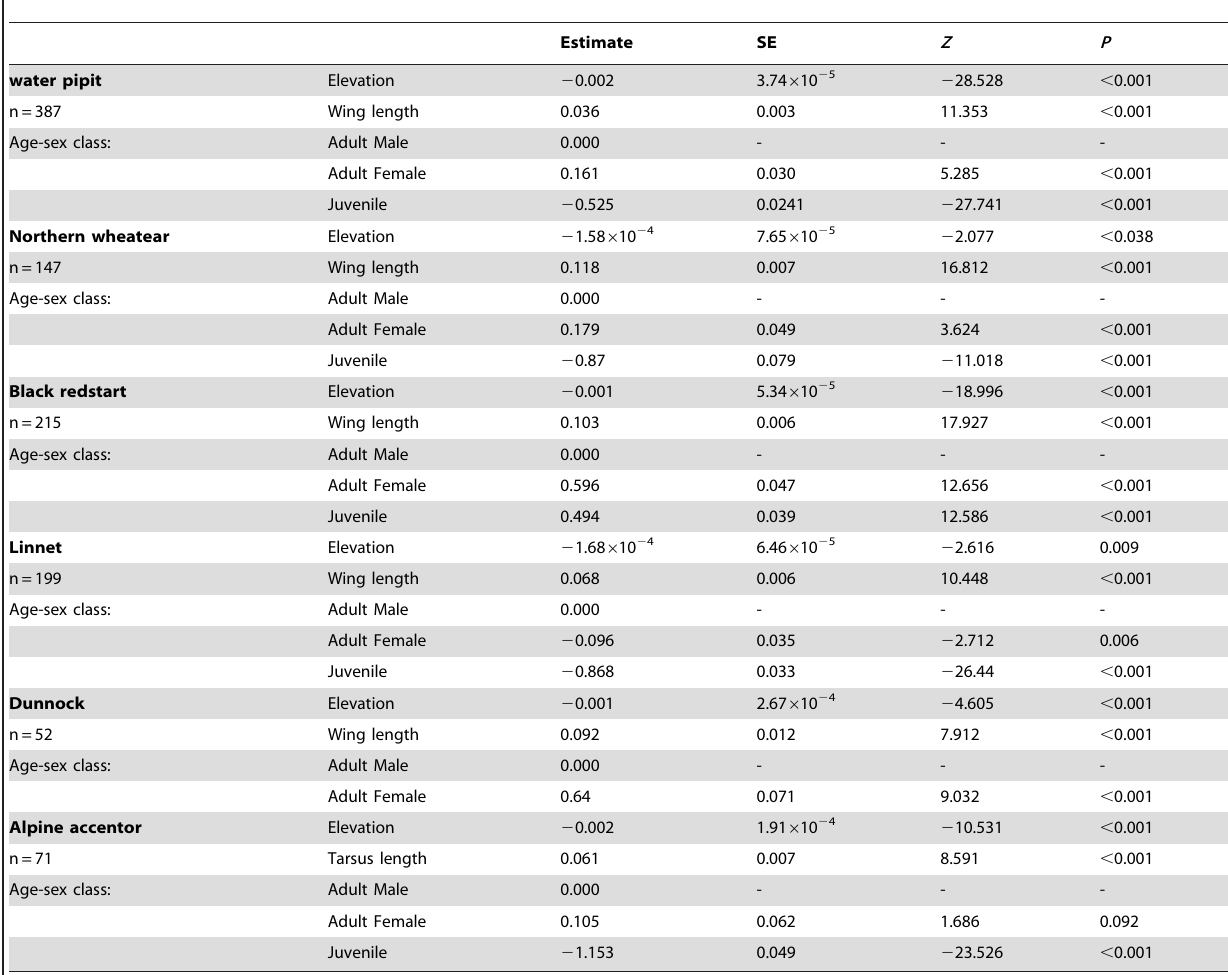
Table 2. Results of generalized linear mixed models testing for the relationship between mite intensity and